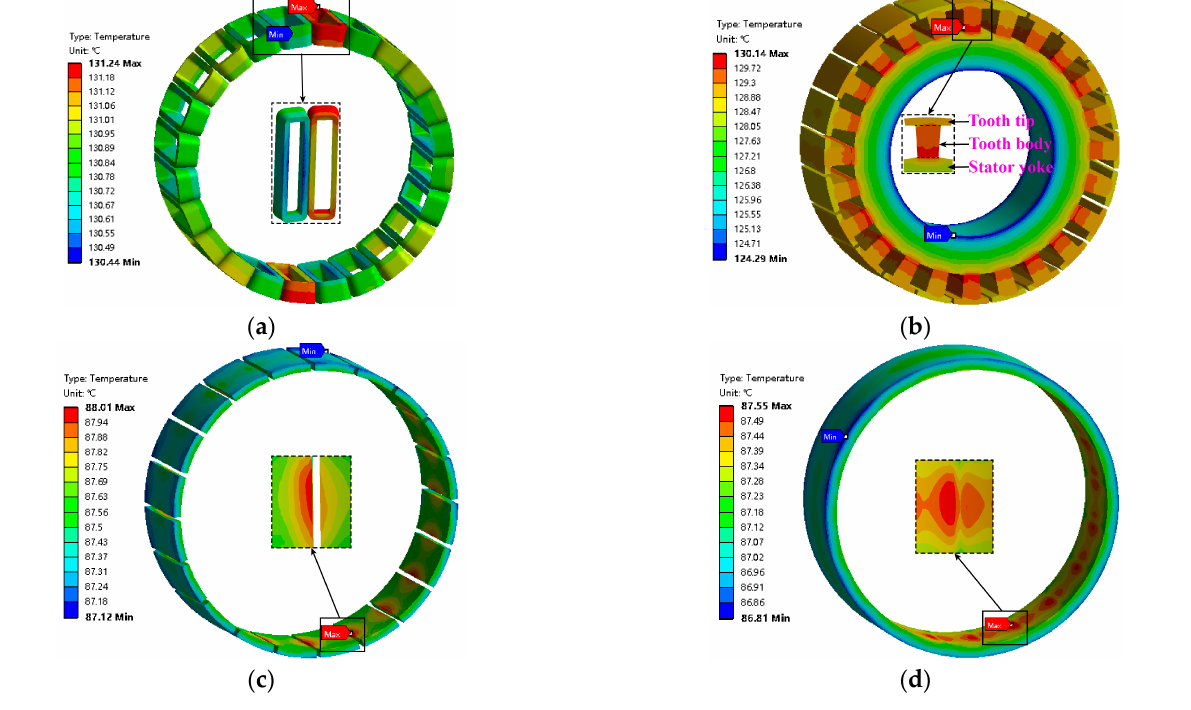
Figure 9. Temperature distribution contour of PM-IWM components under on-load condition: ( a ) Winding; ( b ) Stator core; ( c ) PM; ( d ) Rotor yoke.